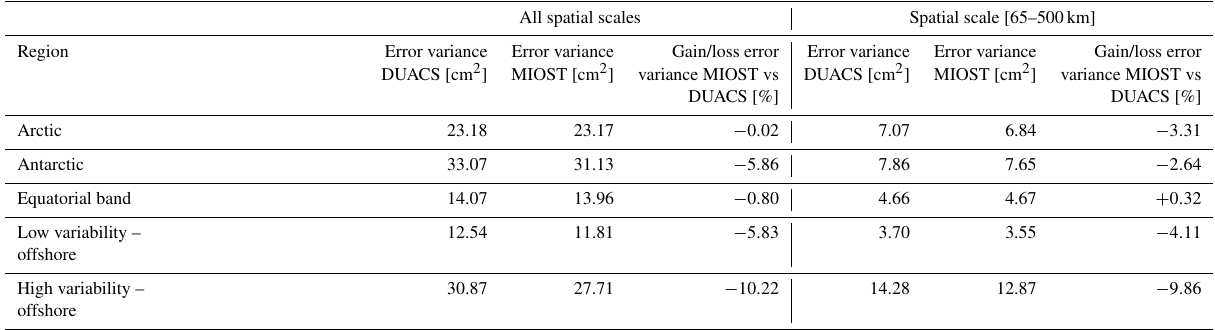
Figure 8. Variance of the difference SSH map − SSH along-track computed for the DUACS allsat-1 experiment and in considering (a) all spatial scales and (b) the spatial scale between 65 and 500km. Gain/loss of the mapping error variance of SLA in the MIOST allsat-1 experiment relative to the DUACS allsat-1 mapping error variance for (c) all spatial scales and (d) the scale between 65 and 500km. Blue colour means a reduction of error variance in MIOST. Table 4. Regionally averaged mapping error variance and gain/reduction of error variance on the SSH variable between MIOST and DUACS. All spatial